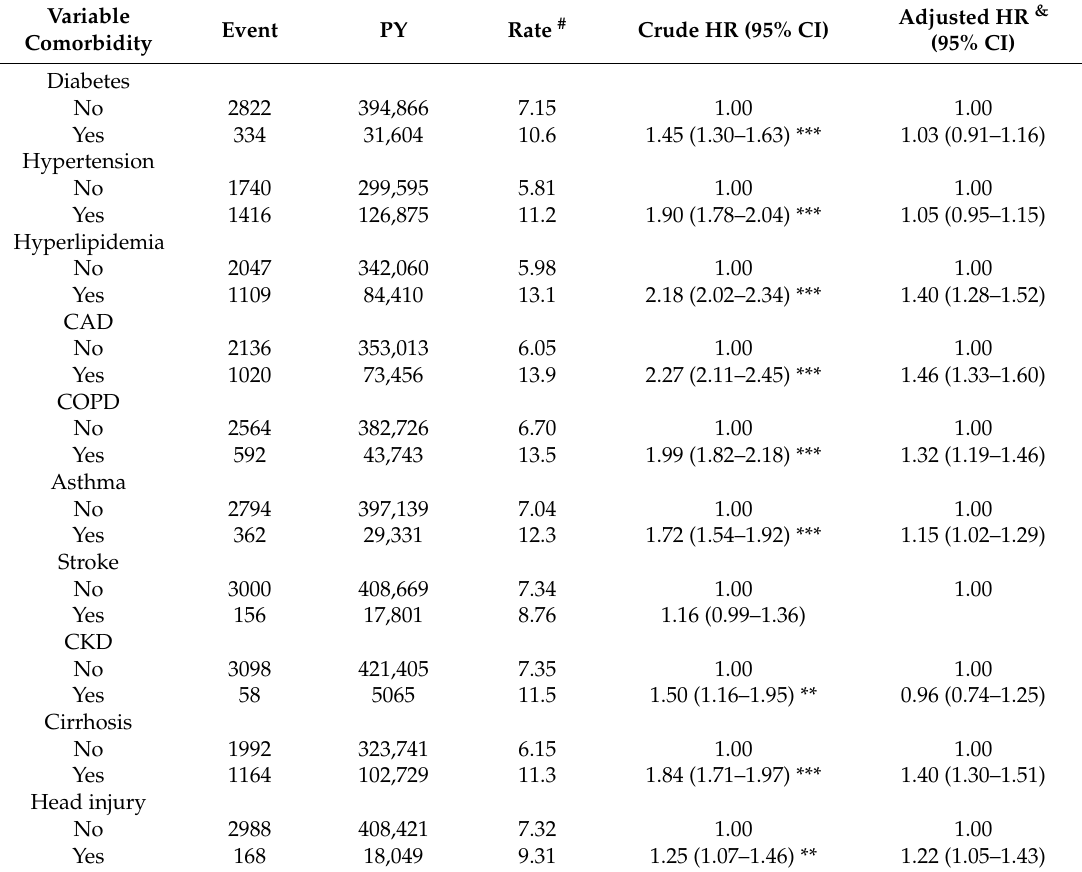
Table 3. Incidences and hazard ratio of cervical spondylosis associated with comorbidity in pooled data of the two